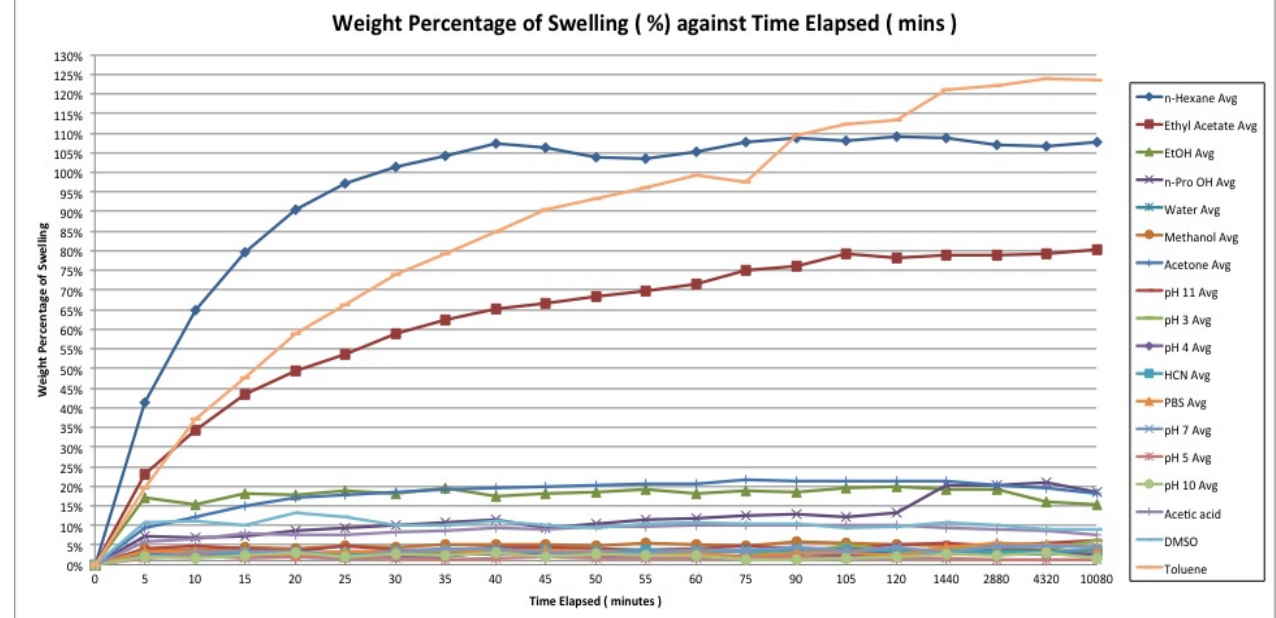
Figure 5. Rates of PDMS sample swelling, based on percentage of weight increase, when immersed in different solvents for a duration time up to 24 h. Organic solvents which causes less than 10% of swelling by weight in the figure are reproduced in Figure